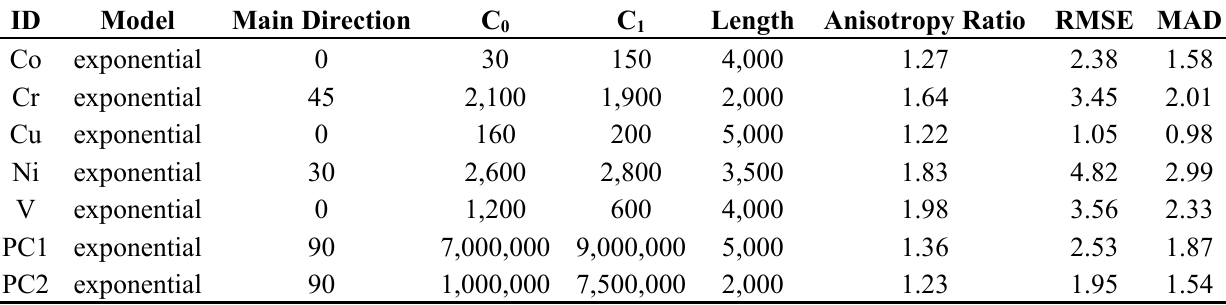
Table 1. Parameters of the theoretical models of spatial continuity fitted to the experimental variogram of Co, Cr, Cu, Ni, V, PC1, and